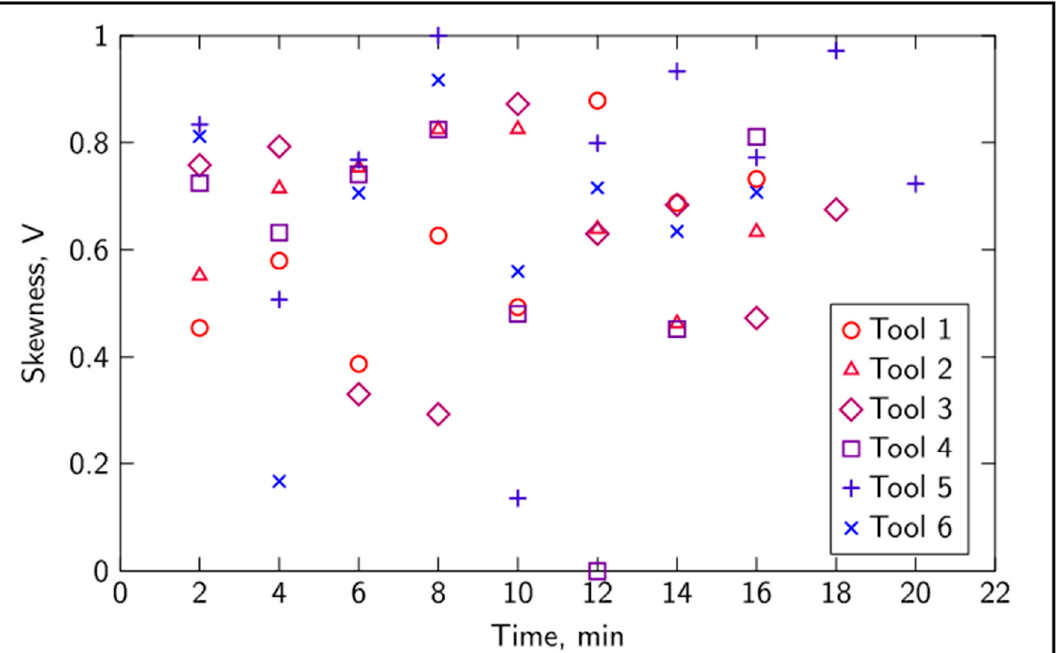
Figure 5. Normalized skewness evolution of sound over time for all tools.